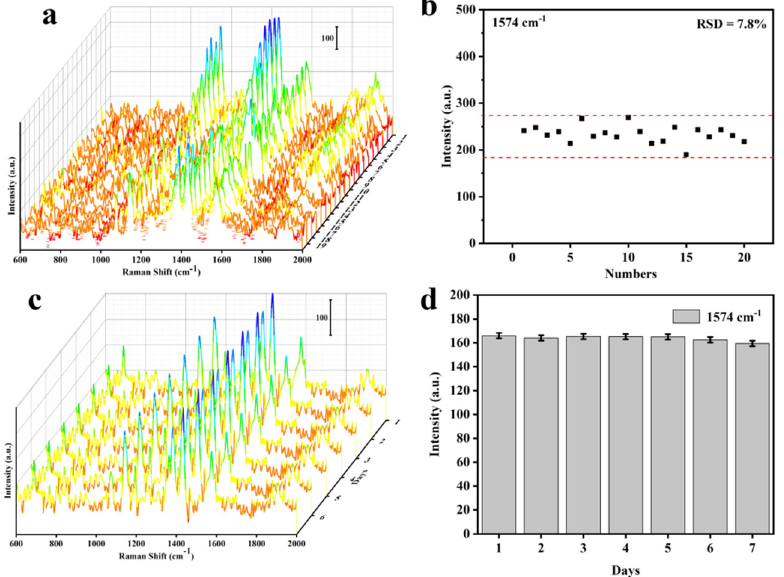
Figure 5. Raman spectra of 10 -5 M 4-NBT on the Cu@Co 3 O 4 @Ag-H substrate. ( a , b ) Raman spectra waterfall plots with 20 points randomly selected from the mapping spectra and corresponding intensity distribution of the 1574 cm -1 peaks of 4-NBT collected for RSD analysis. ( c , d ) Raman spectra waterfall plots of the 4-NBT on the Cu@Co 3 O 4 @Ag-H substrate at different collection times and corresponding intensity variation of the 1574 cm -1 peaks of 4-NBT collected for intensity reduction analysis.